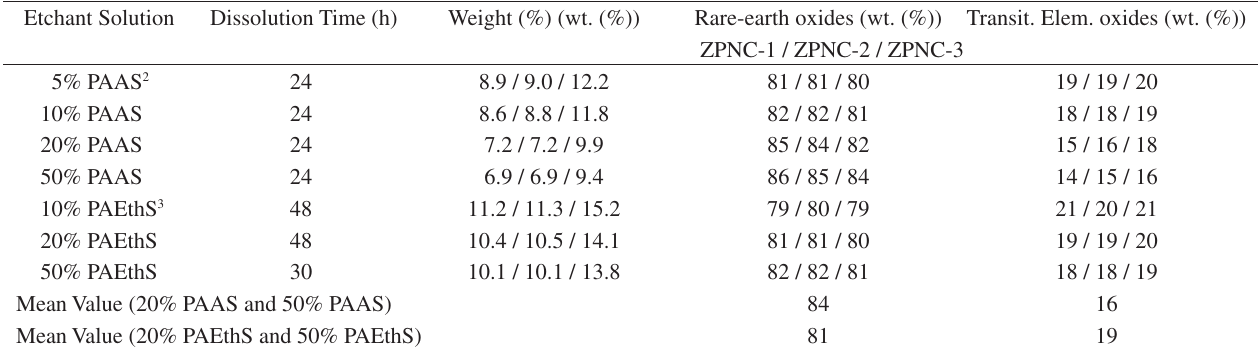
Table 3. Results of residue analysis (XRF) of the leached ZPNC samples 1 . Etchant Solution